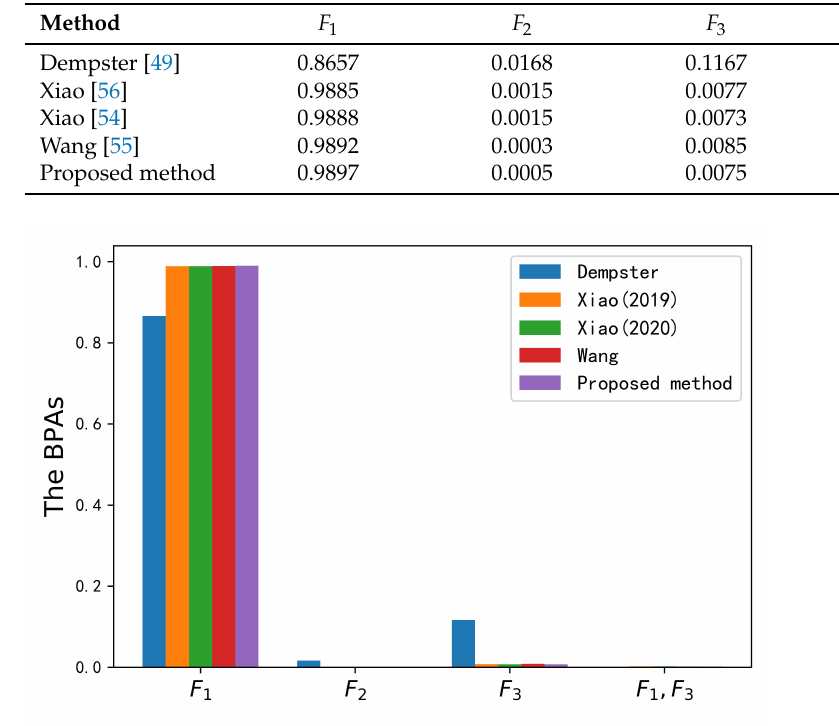
Figure 5. Fusion results from different methods in Application